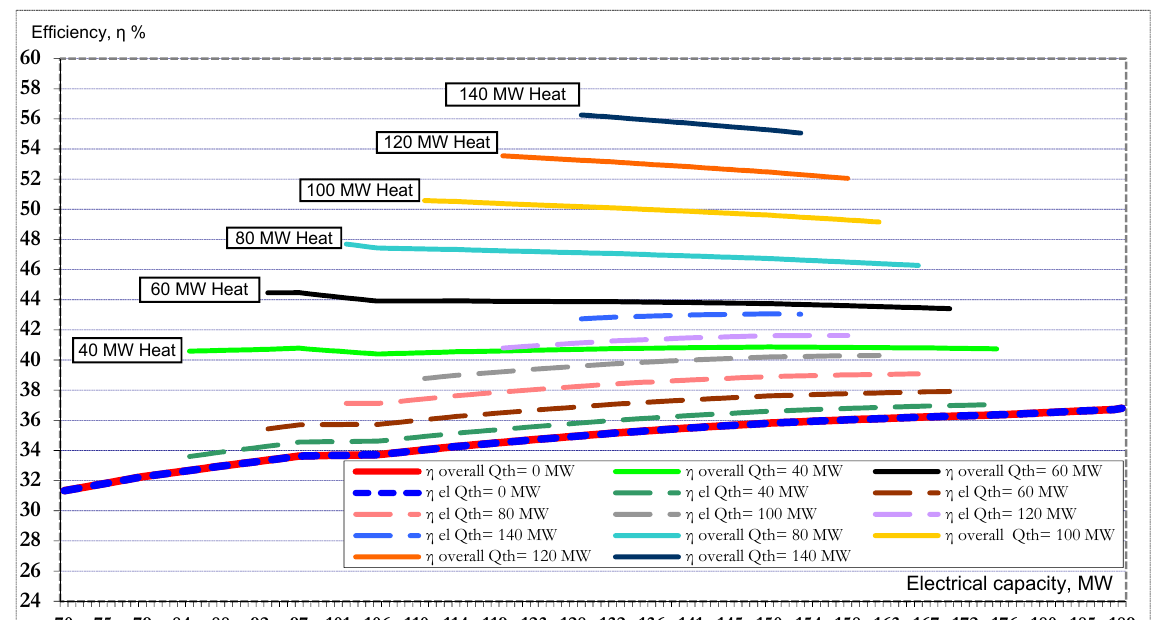
Figure 9. Overall and electrical efficiency of the CHP unit based on the heat load.